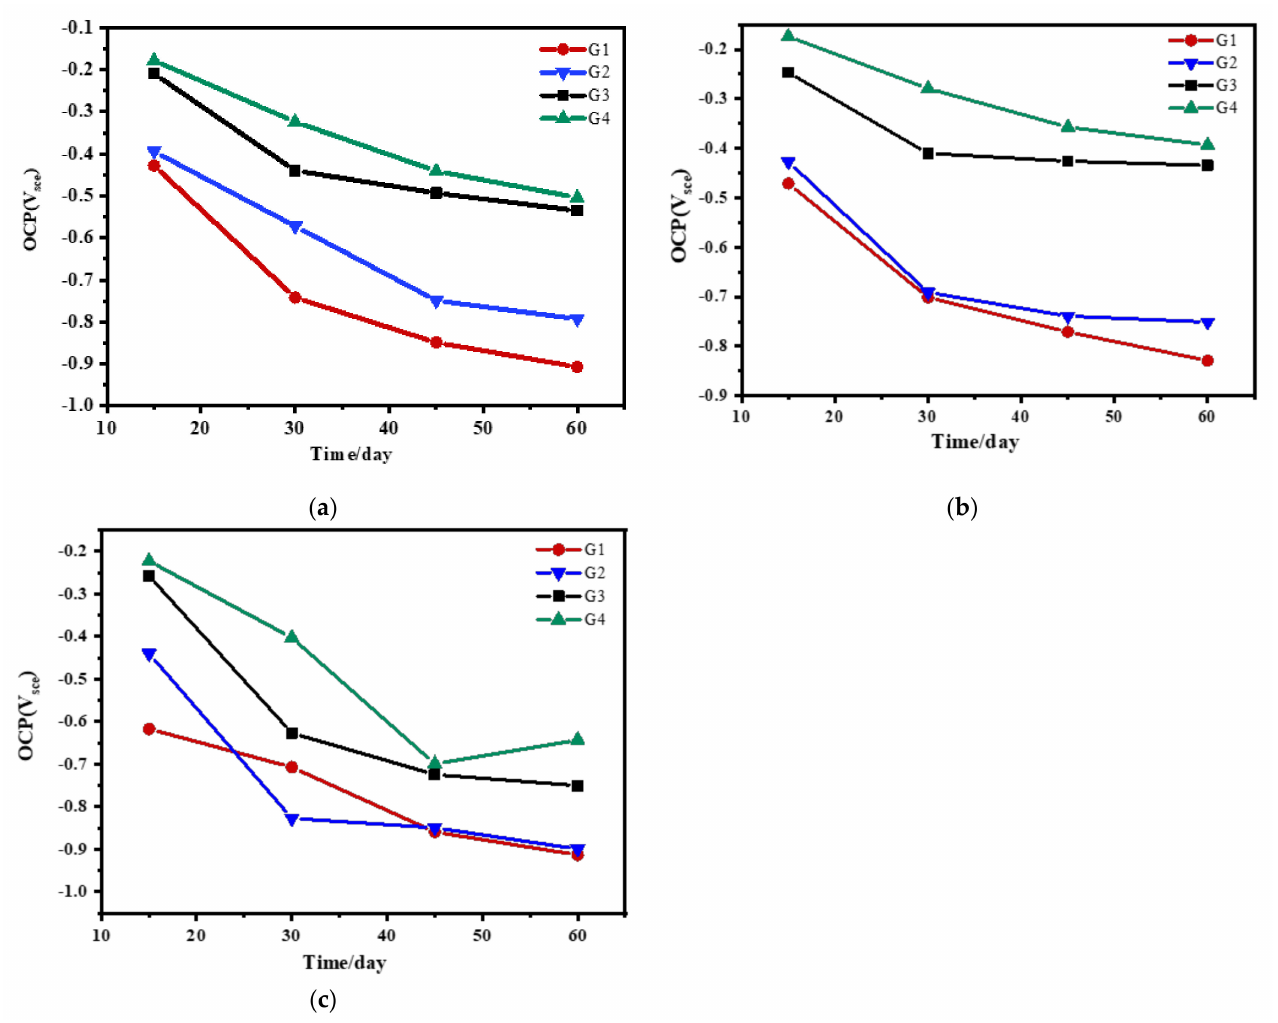
Figure 3. Each coating’s OCP for immersion for 60 days: ( a ) 20% Seawater; ( b ) 40% Seawater; ( c )